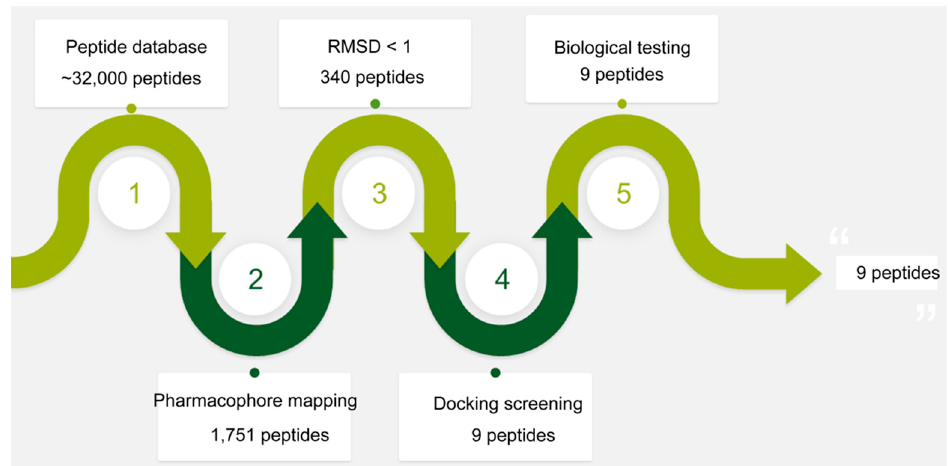
Figure 2. A workflow overview of pharmacophore modeling, selection of compounds, and biological testing. Table 2. Results of root mean square distance (RMSD) values and docking scores of the 9 selected peptides. Peptides Sequence